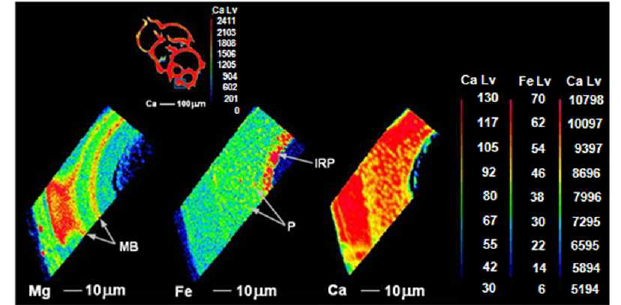
Fig. 1. EMP elemental mappings for an Uvigerina peregrina speci- men from 519 m water depth (M77-1-421/MUC-13) on an exposed section of the foraminiferal test. Distribution of Ca, Mg and Fe in the foraminiferal test. All intensity values are expressed in counts per second (cps) as shown in the color bars. MB: Mg bands IRP: Fe rich phase at inner test surface and pores